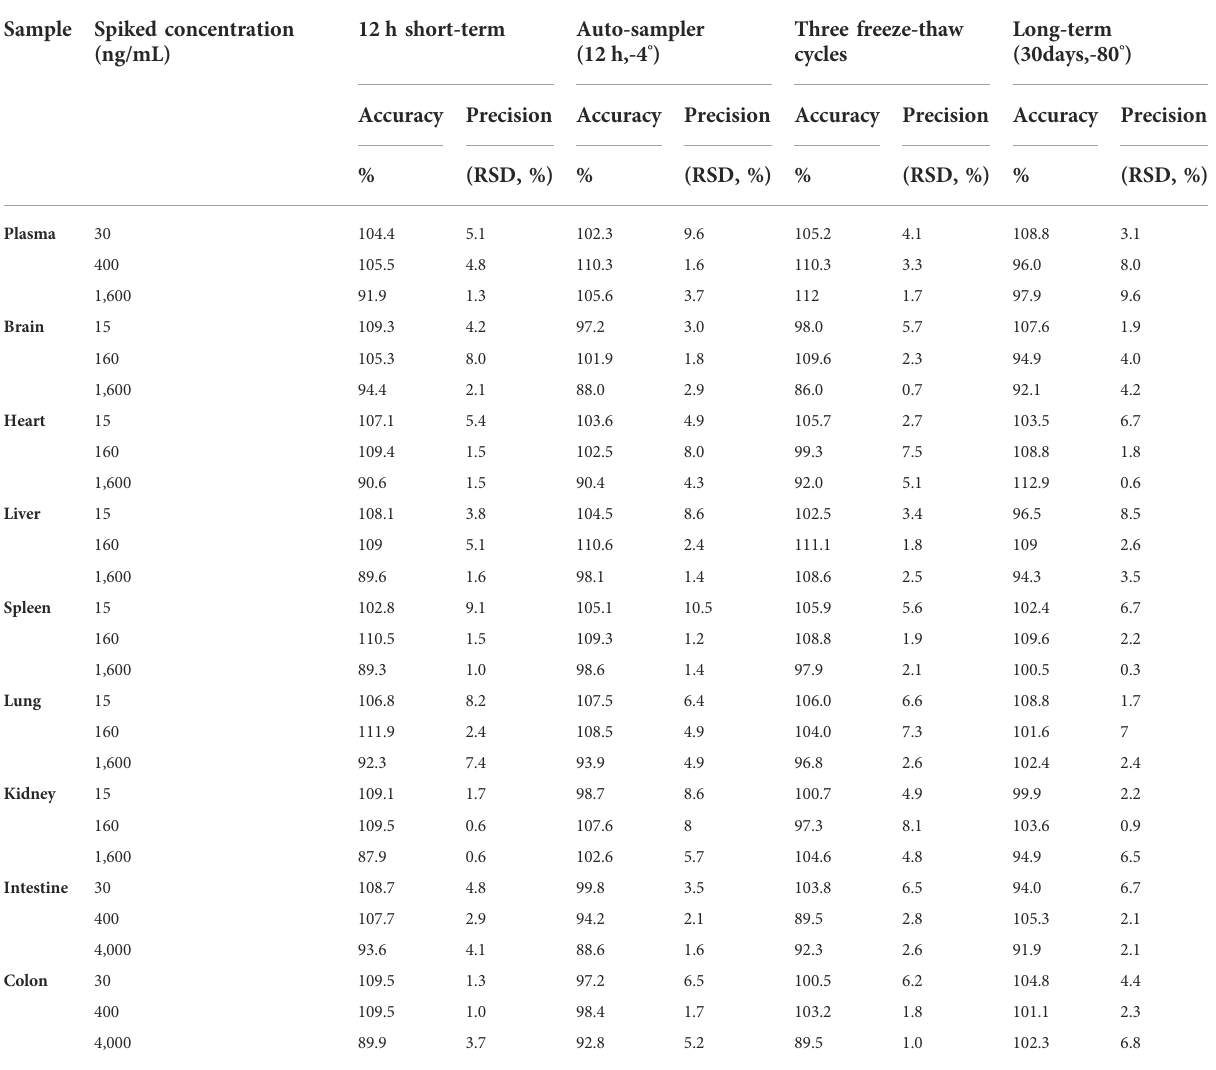
TABLE 4 Stability of curcumol in rat plasma and tissue homogenates (n = 5). Sample Spiked concentration